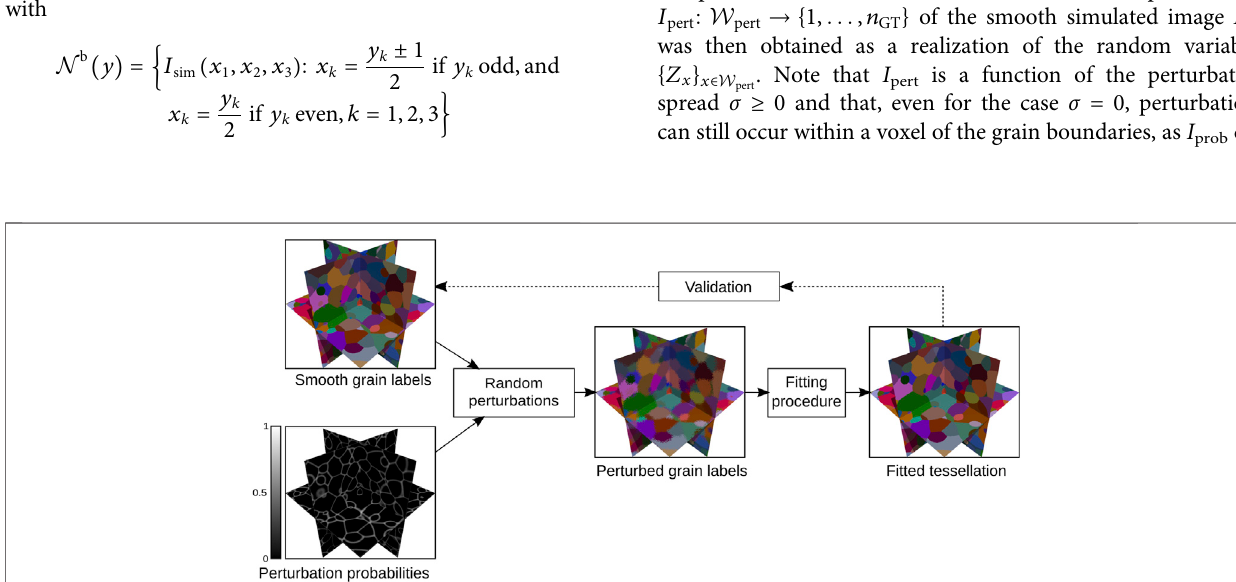
FIGURE 4 | Schematic overview of the generation of perturbed simulated grain labels and validation of their fi ts. Orthogonal 2D slices through 3D datasets are shown.